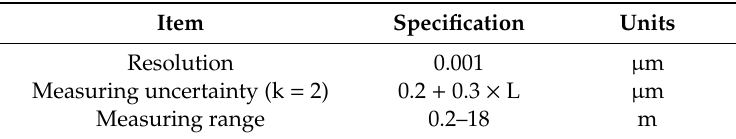
Table 4. LaserTRACER specifications.